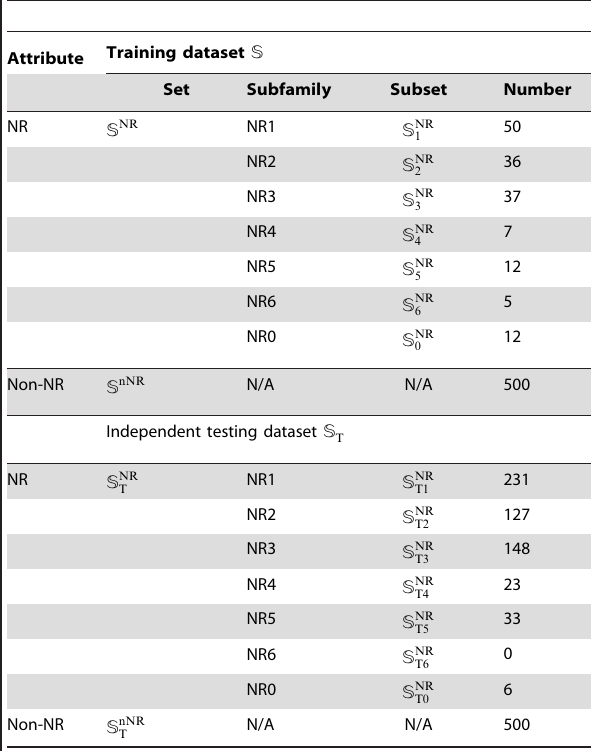
Table 1 . Breakdown of the learning dataset S and testing dataset S T .